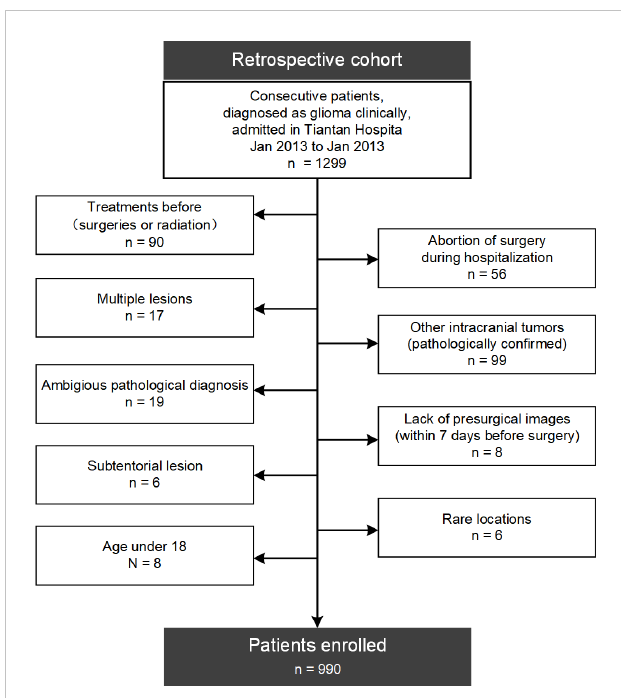
FIGURE 1 Flow diagram of patients ’ enrollment. 990 adult patients with newly- diagnosed supratentorial diffuse gliomas were fi nally enrolled from a retrospective cohort of 1299 patients in this